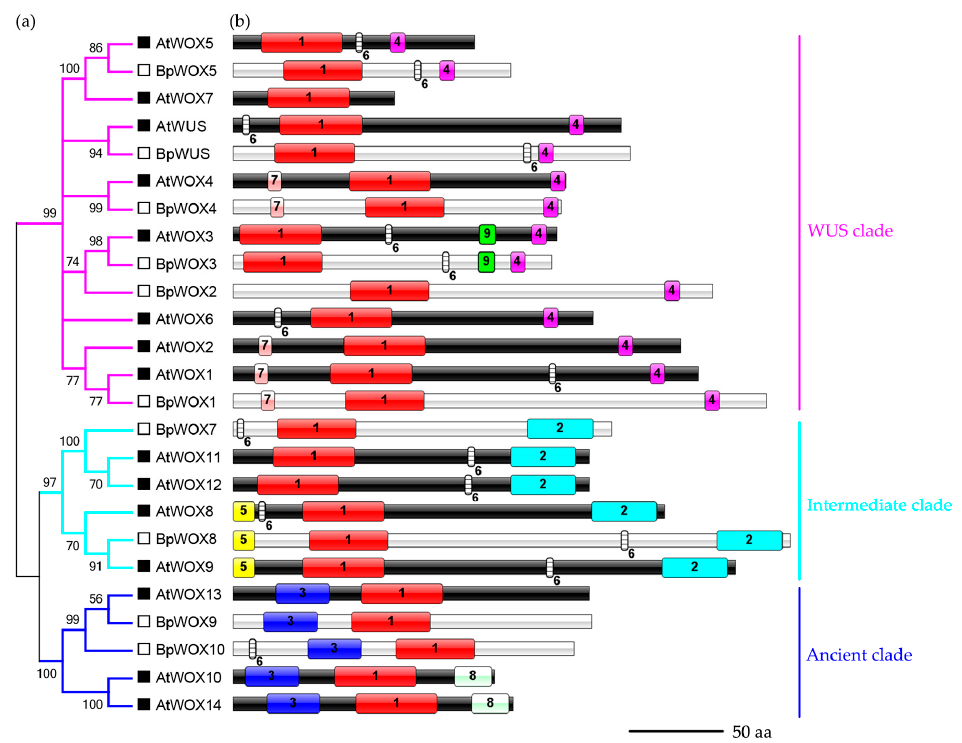
Figure 3. Phylogenetic tree and conserved motif analysis of WOX family between A. thaliana and paper mulberry. ( a ) The phylogenetic tree (NJ) was reconstructed by MAGE6 using 24 sequences from A. thaliana and paper mulberry. The WUS clade, intermediate clade, and ancient clade were colored with pink, sky-blue and navy blue, respectively. The BpWOX proteins were represented by black filled boxes, and the AtWOX proteins were represented by black blank boxes; ( b ) The conserved motifs among the members are highlighted in colored boxes with an arranged number, and the sequences of the motifs are listed in Supplementary Table S7. A total of nine motifs was observed from the motif elicitation tool MEME (Supplementary Figure S12). Motif 1 (red boxes) was homeodomain (HD) and motif 4 (pink boxes) was the WUS-box. Motif 2 (sky-blue boxes) only appeared in the intermediate clade and motif 3 (navy-blue boxes) was unique to the ancient clade. The other motifs are distinguished by colors except for motif 6 (white plaid). Motif 5 is labeled by yellow boxes, motif 7 is labeled by water-red boxes, motif 8 is labeled by white boxes, and motif 9 is labeled by green boxes. Bar = 50 aa.